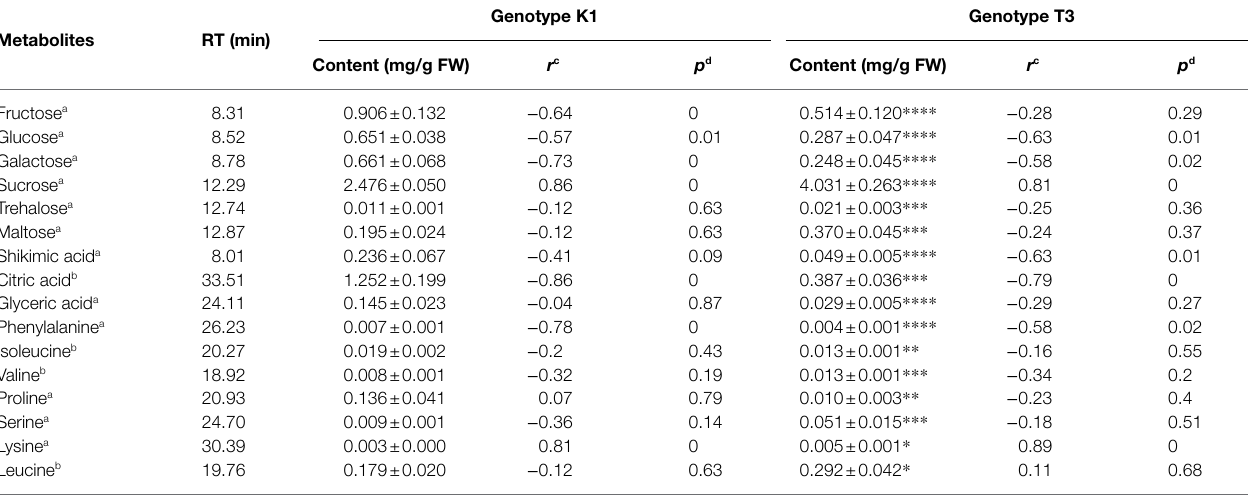
TABLE 1 | Important primary metabolites based on the PLSR contributed to the separation of genotype Kreuzkogel 1 (K1) and Tenno 3 (T3). Genotype K1 Genotype T3 Metabolites RT (min) Content (mg/g FW) r c p d Content (mg/g FW) Fructose